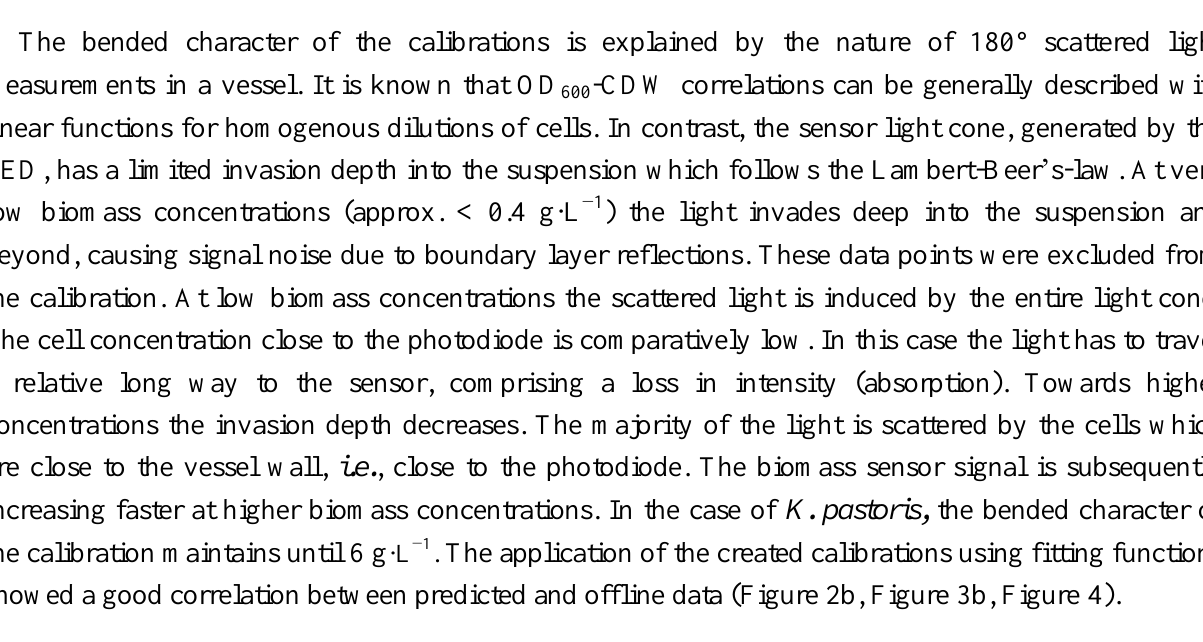
Figure 4. Application of the calibration function of A. niger on the biomass sensor signal of the validation growth curve along with the offline measured